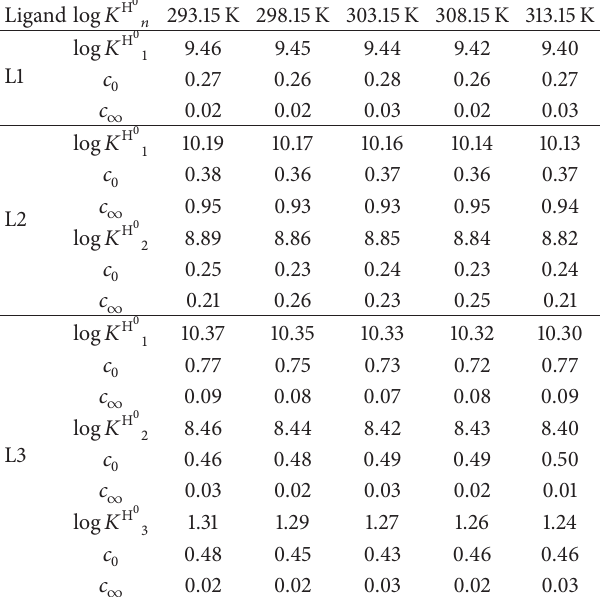
0 species, 𝑆 0 , for naphthalen-1-ol and naphthalene-1,5-diol/4- ± Table 4: The protonation constants at infinite dilution (log 𝐾 H 𝑛 amino-3-hydroxynaphthalene-1-sulphonic acid, 𝑐 0.001 ) and parameters ( 𝑐 0 and ∞ ) for the dependence of the protonationconstantsonionicstrengthforL1,L2,andL3atdifferent temperatures.